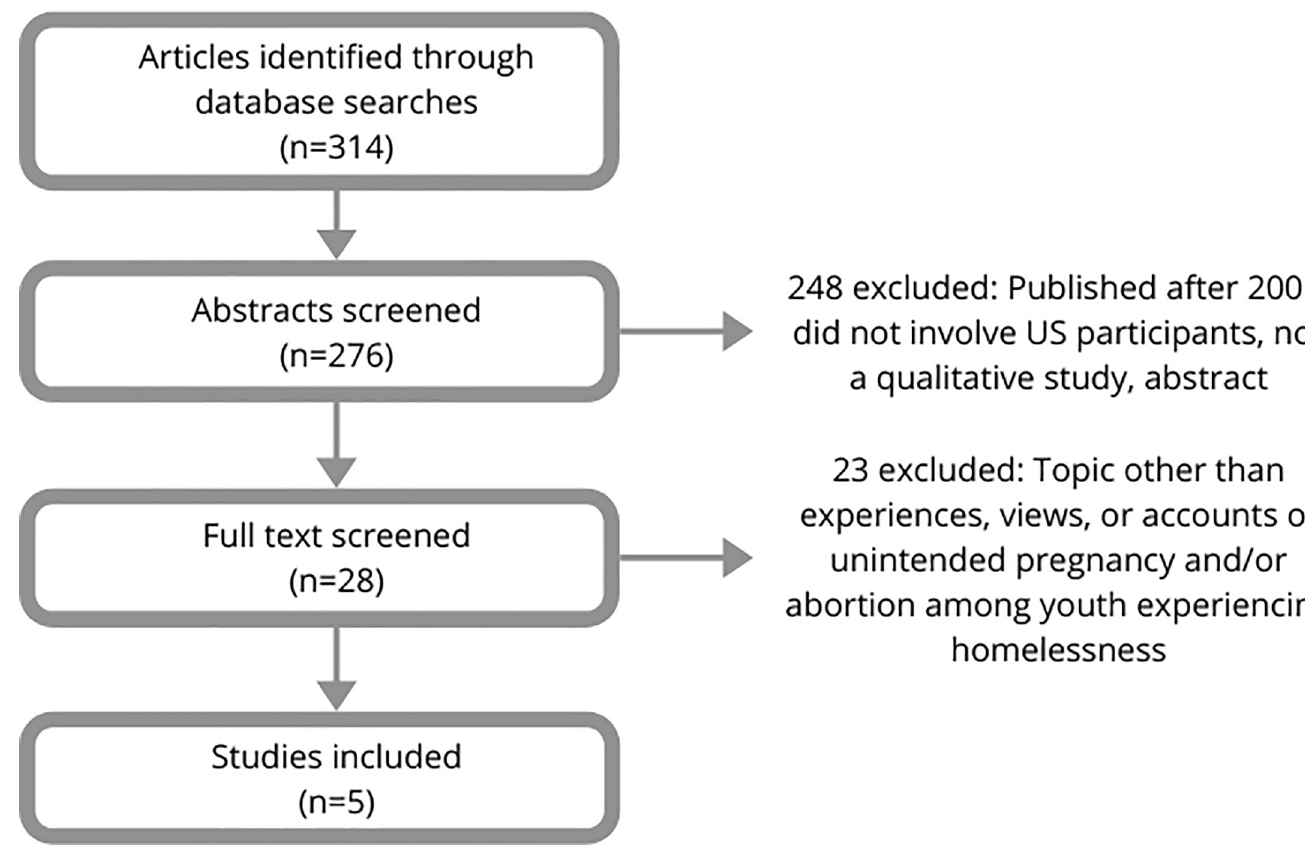
Fig 1. Selection of included studies.